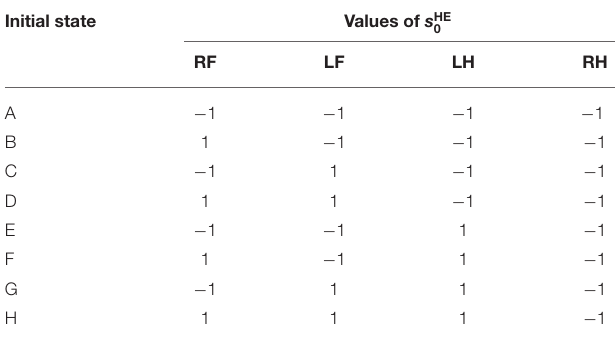
TABLE 2 | List of initial conditions (value of s HE 0 ) at the beginning of the walking